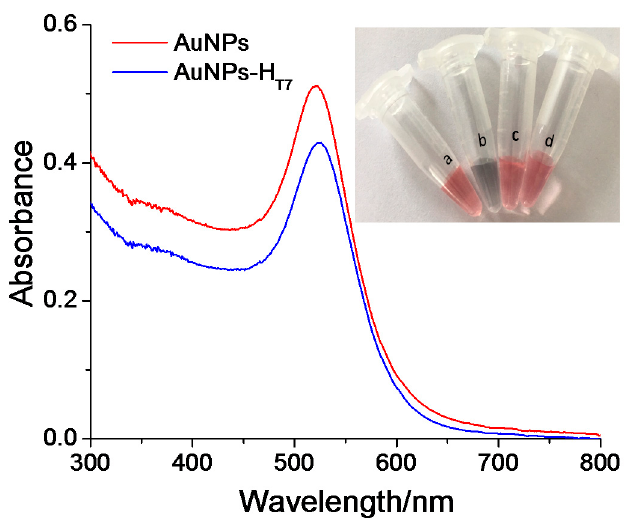
Figure 1. UV–vis spectra of AuNPs and AuNPs ‐ H T7 . The inset shows the photographs of (a) AuNPs, (b) AuNPs with 0.15 mol/L NaCl, (c) AuNPs ‐ H T7 and (d) AuNPs ‐ H T7 with 0.15 mol/L NaCl.